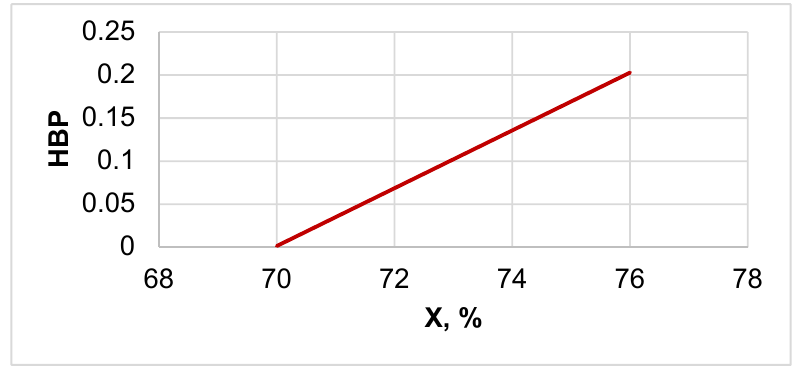
Figure 5. Dependence of hydrophobicity of cellulose samples on their crystallinity.